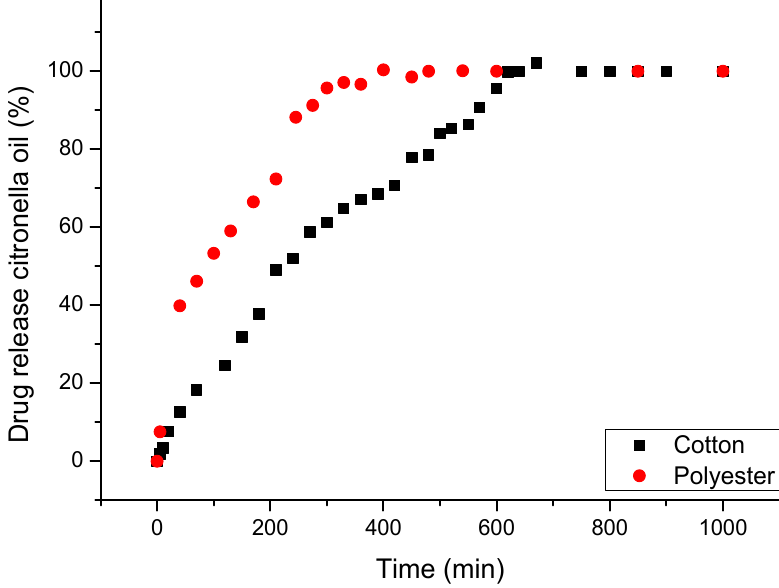
Figure 9. In vitro controlled release profiles in water at 37 °C for complexes (citronella: β CD) applied on textiles.